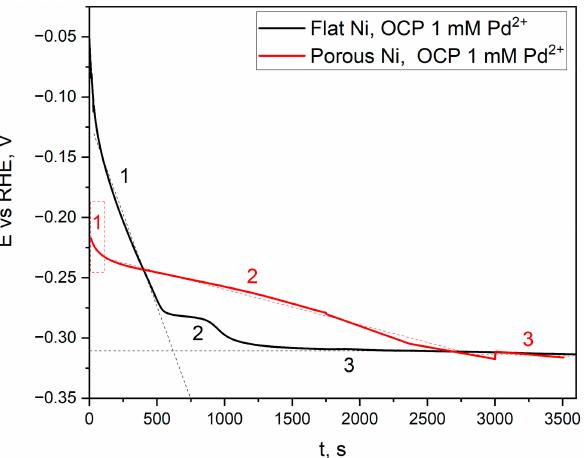
Figure 5. Open-circuit measurements for the flat Ni (black) and porous Ni (red) samples immersed in the 1 mM PdCl 2 + 0.1 M HCl solution for 3600